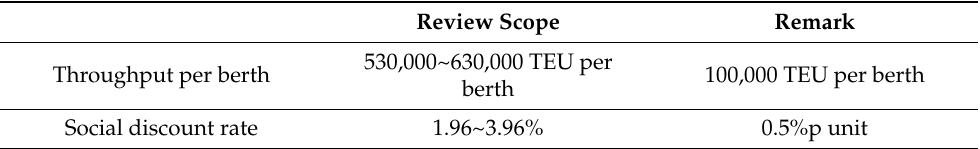
Table 1. Sensitivity analysis criteria.